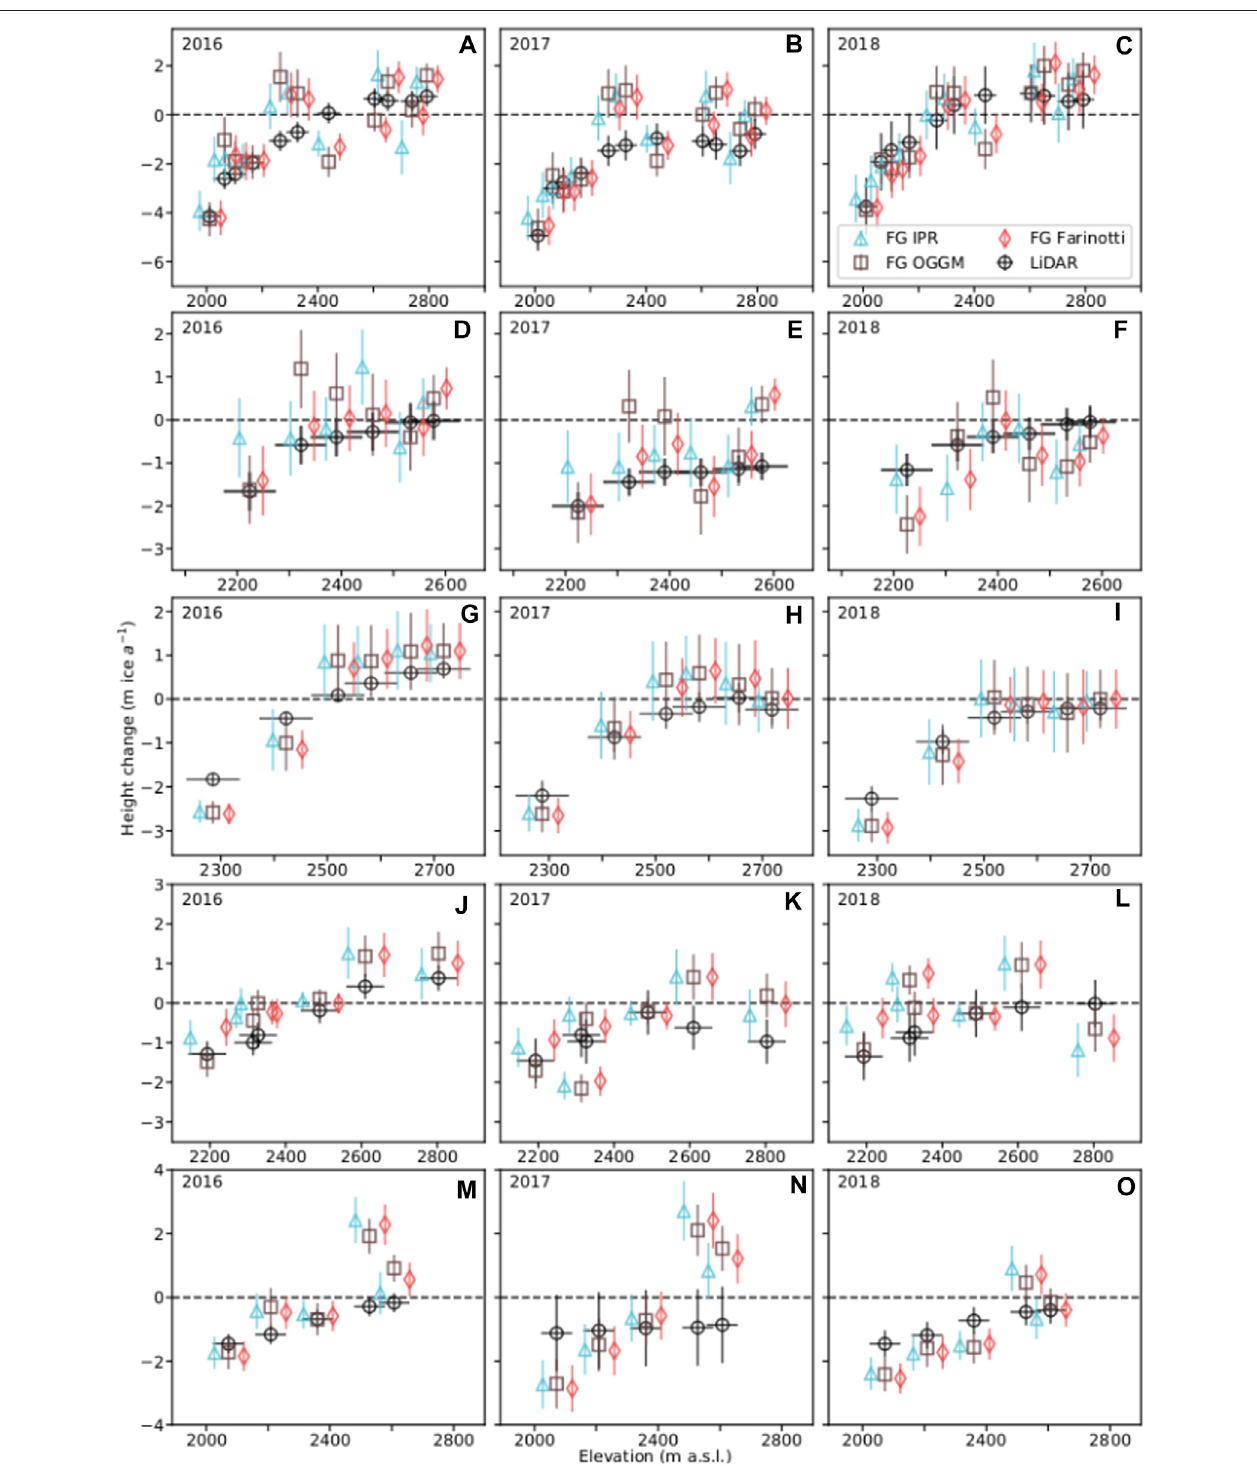
FIGURE 11 | Mass conservation plot Conrad (A – C) , Illecillewaet (D – F) , Kokanee (G – I) , Nordic (J – L) and Zillmer (M – O) glaciers for 2016, 2017, and 2018. The black error bars represent ALS-derived dh / dt ± σ dh / dt for each fl ux bin. The colored error bars represent the sum of observed b a height change ( h ) and V z and, if mass conservationisrespected,willequaltheALS dh / dt .ThisassumesthattheALSand fi eldobservationscapturetheglacieratthesametime;IllecillewaetGlacierlacksGPS surveys to correct for height change between ALS and fi eld surveys.